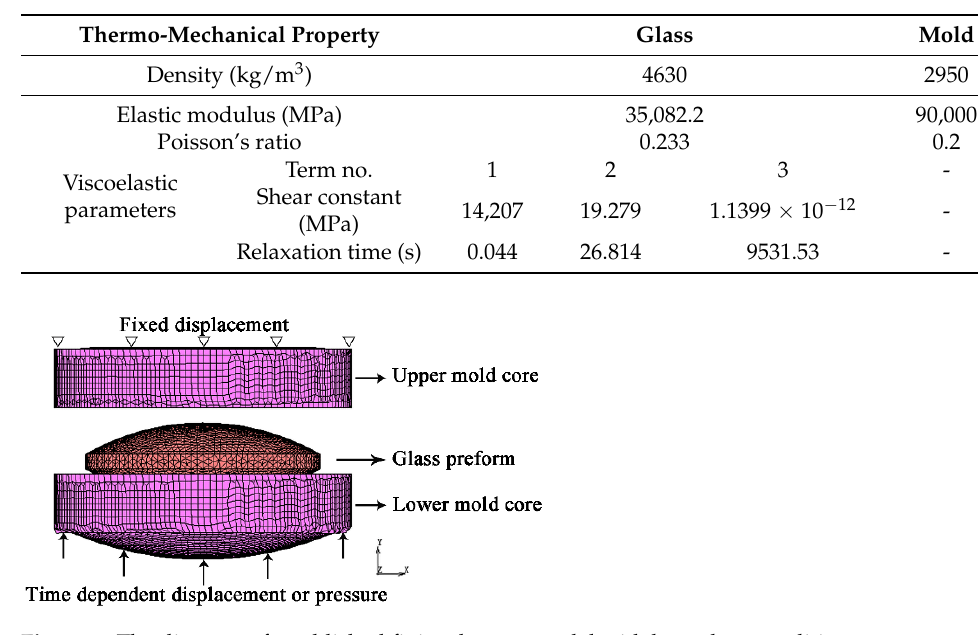
Table 4. Thermodynamic characteristics of the glass and mold used in the simulation.